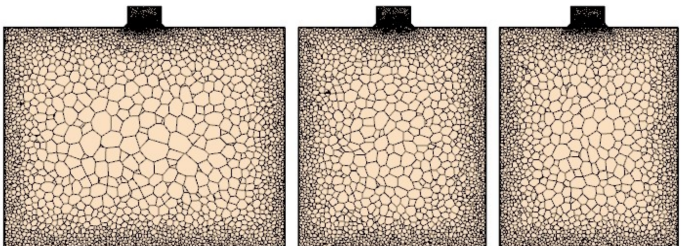
Figure 6. Example of polyhedral mesh with adaptive refinement used for simulations (cross- sectional view).